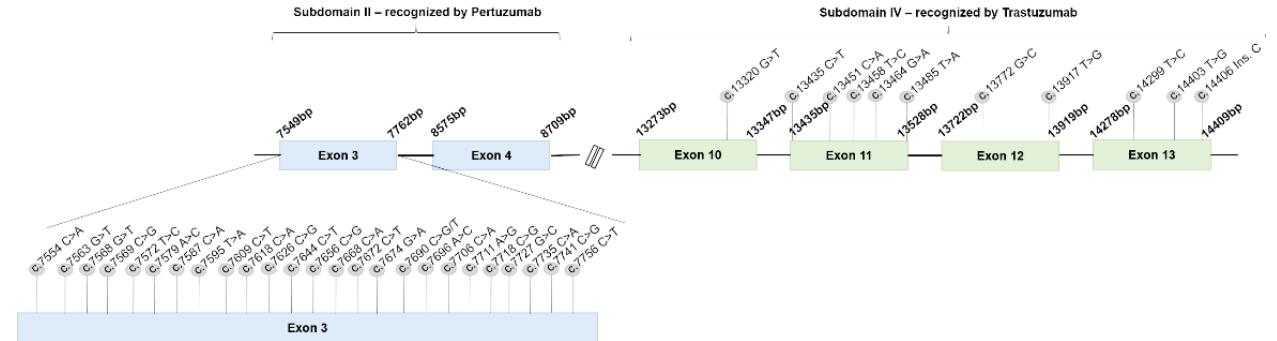
Figure 7. Mutations identified in the feline her2 ECD, subdomains II and IV were not reported as induce resistance to therapy. All the mutations found occur in a low frequency (n = 1), being more common in exon 3, subdomain II (69.4%). Any of the described mutations were reported in breast cancer patients as induce therapeutic resistance.